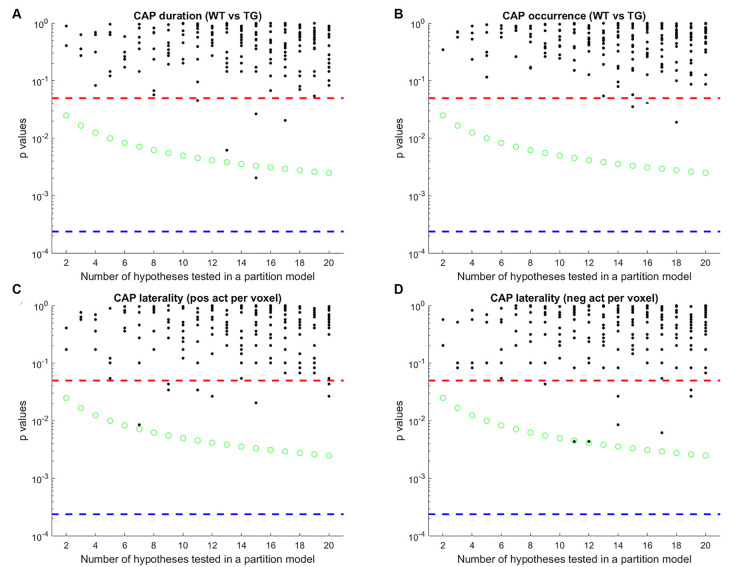
Each panel shows the p-values of comparison of median duration (A) occurrence rate (B) laterality of average positive activation per voxel (C) and, laterality of average negative activation per voxel (D) between WT and TG groups for each CAP in each partition with the number of clusters ranging from 2 to 20. Thus each black marker represents a CAP. The red dashed line represents a p-value of 0.05, uncorrected. The green marker represents Bonferroni corrected threshold p-value for each partition. The blue dashed line represents the Bonferroni corrected threshold p-value across partitions. Here, CAPs are extracted from a single image-series formed by concatenating both group-level image-series. Unlike Figure 5, here very few CAPs showed significant WT-TG difference after correcting for multiple comparisons within the partition.